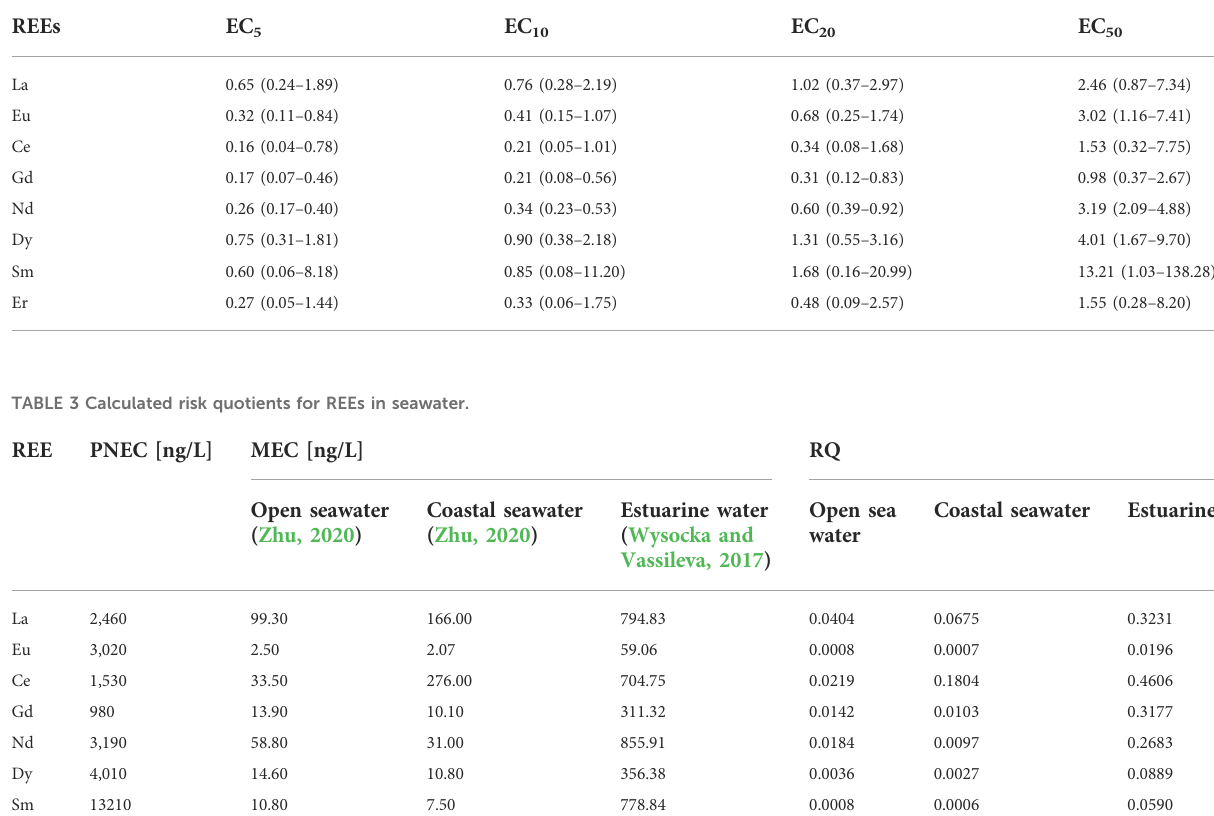
TABLE 2 EC 5 , EC 10 , EC 20 , and EC 50 values for Ce, Dy, Eu; La and Nd on P. tricornutum ; values are in mg/L; n.a. = not available; REEs = rare earth elements; EC = effective concentration; average EC values are provided ±95% con fi dence limit values in brackets ( n = 3).